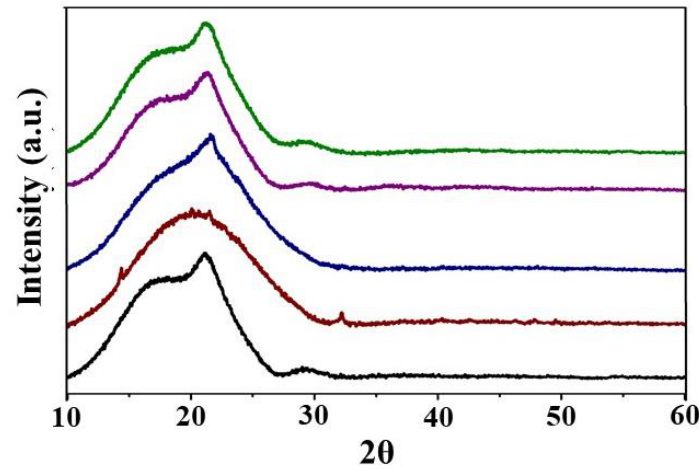
Fig. 5: X-ray diffractograms of pectin ( ▲ ), LS extract ( ▲ ), S8 ( ▲ ), S5 ( ▲ ), and S2 ( ▲ ) formulations.